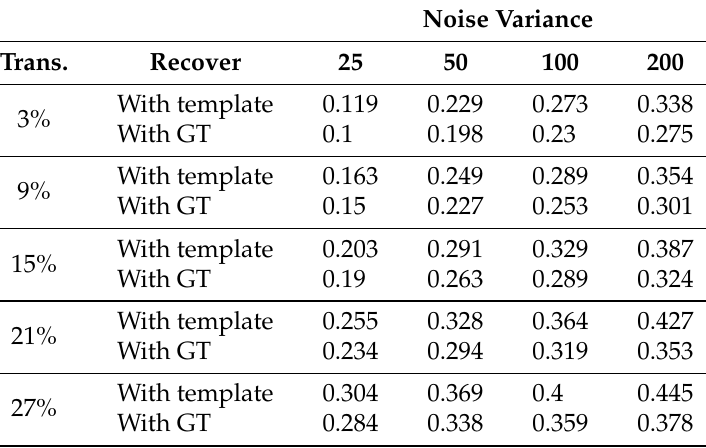
Table 4. Average BER for translation attack with Gaussian